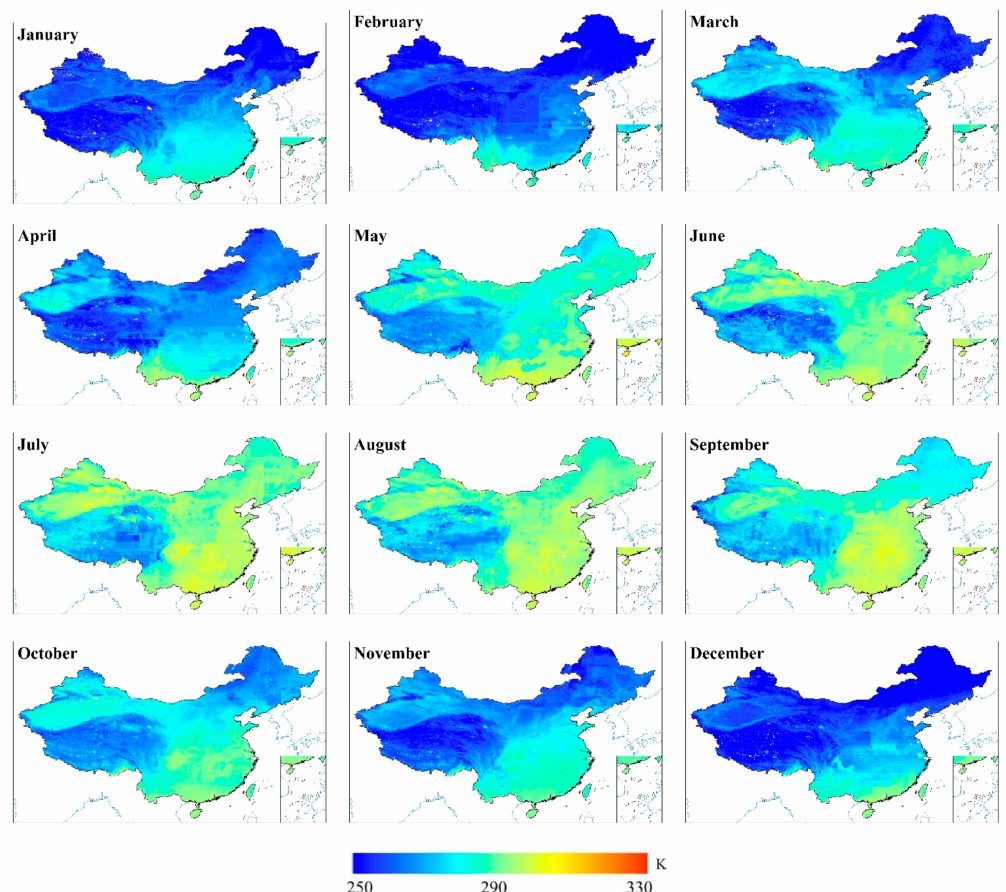
Figure 13. Spatial distribution of the complete all-weather LST during nighttime of the 17th, 46th, 76th, 103rd, 141st, 164th, 196th, 228th, 260th, 292nd, 318th, and 346th days of the year 2010, representing different months.